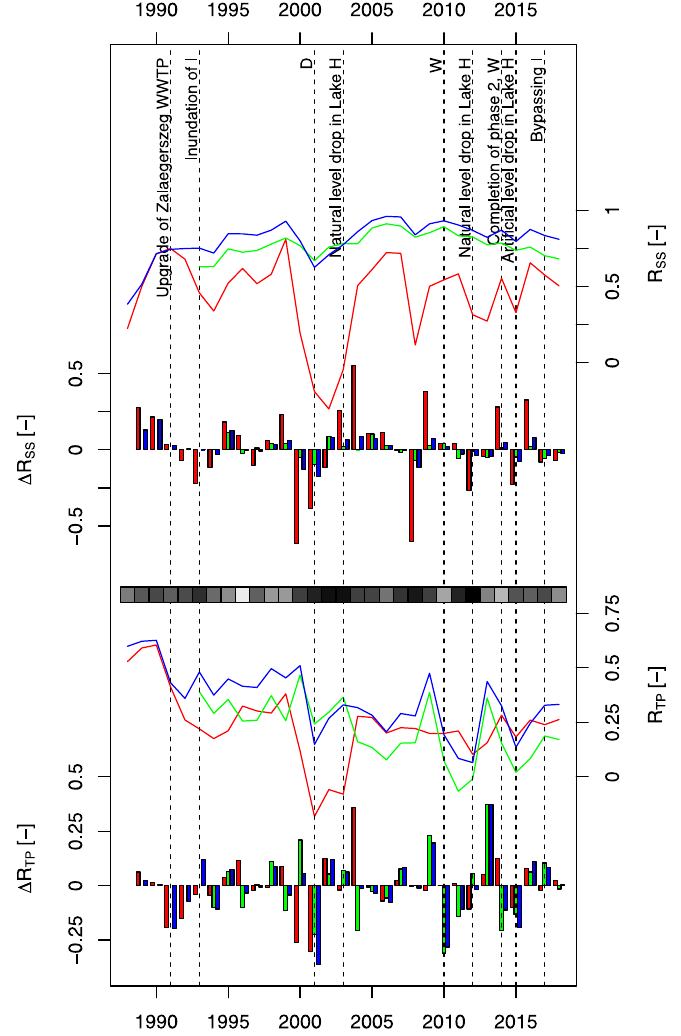
Figure 8. Retentions of SS (R SS ) and TP (R TP ) and their annual changes ( Δ R SS and Δ R TP , respectively). Red: Lake H, green: phase 2, blue: entire system. The grayscale ribbon indicates the relative magnitude of flow at Z, dark: minimal, light: maximal. “W” and “D” indicate extremely wet and dry years, respectively.